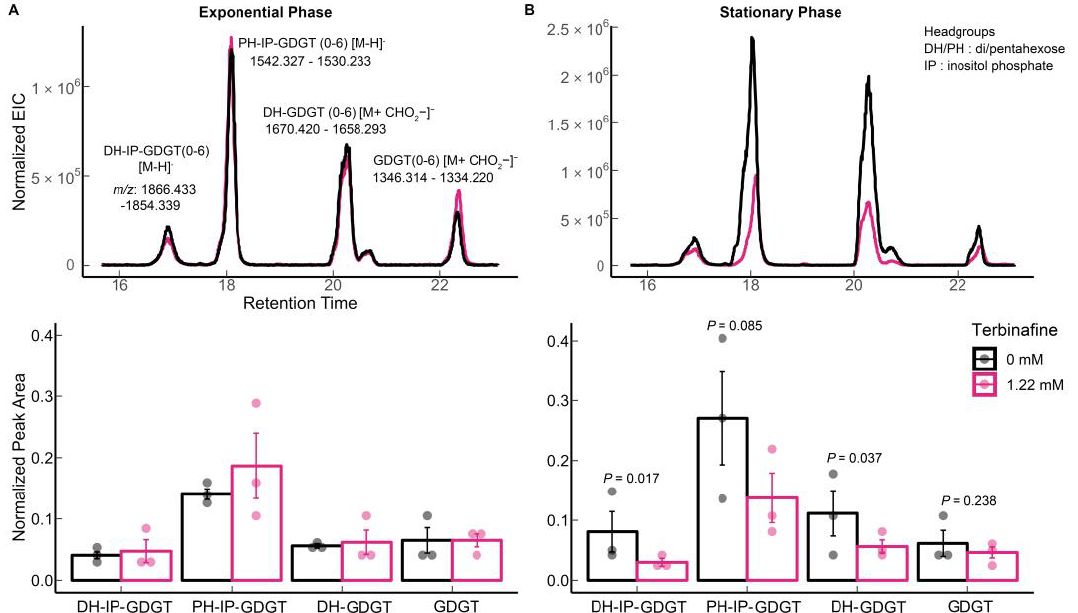
Figure 5. Effect of terbinafine on monolayer forming membrane lipids (GDGTs) of S. acidocaldarius : Extracted ion chromatograms and relative quantification of tetraether lipids in ( A ) exponential phase and ( B ) stationary phase of growth. Error bars represent the standard error of the mean, and p -values are indicated for each lipid species. The numbers in parentheses indicate the number of cyclopentane rings. The dots represent biological replicates. The theoretical m / z values are shown in the figure. The EICs values were normalized to the amount of lipids using the internal standard DOPG.